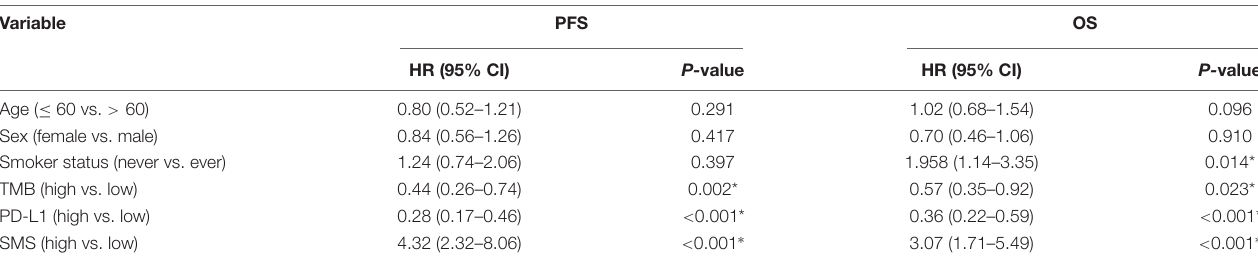
TABLE 2 | Multivariate analyses of PFS and OS in combination cohort ( n = 144).